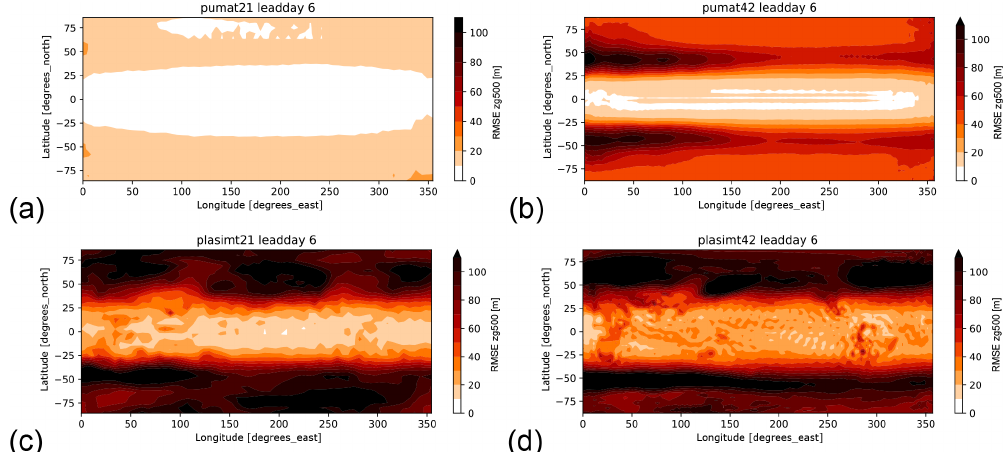
Figure 4. Maps of RMSE of the 6d network forecasts, for the networks trained with 100 years for pumat21 (a) , pumat42 (b) , plasimt21 (c) and plasimt42 (d)